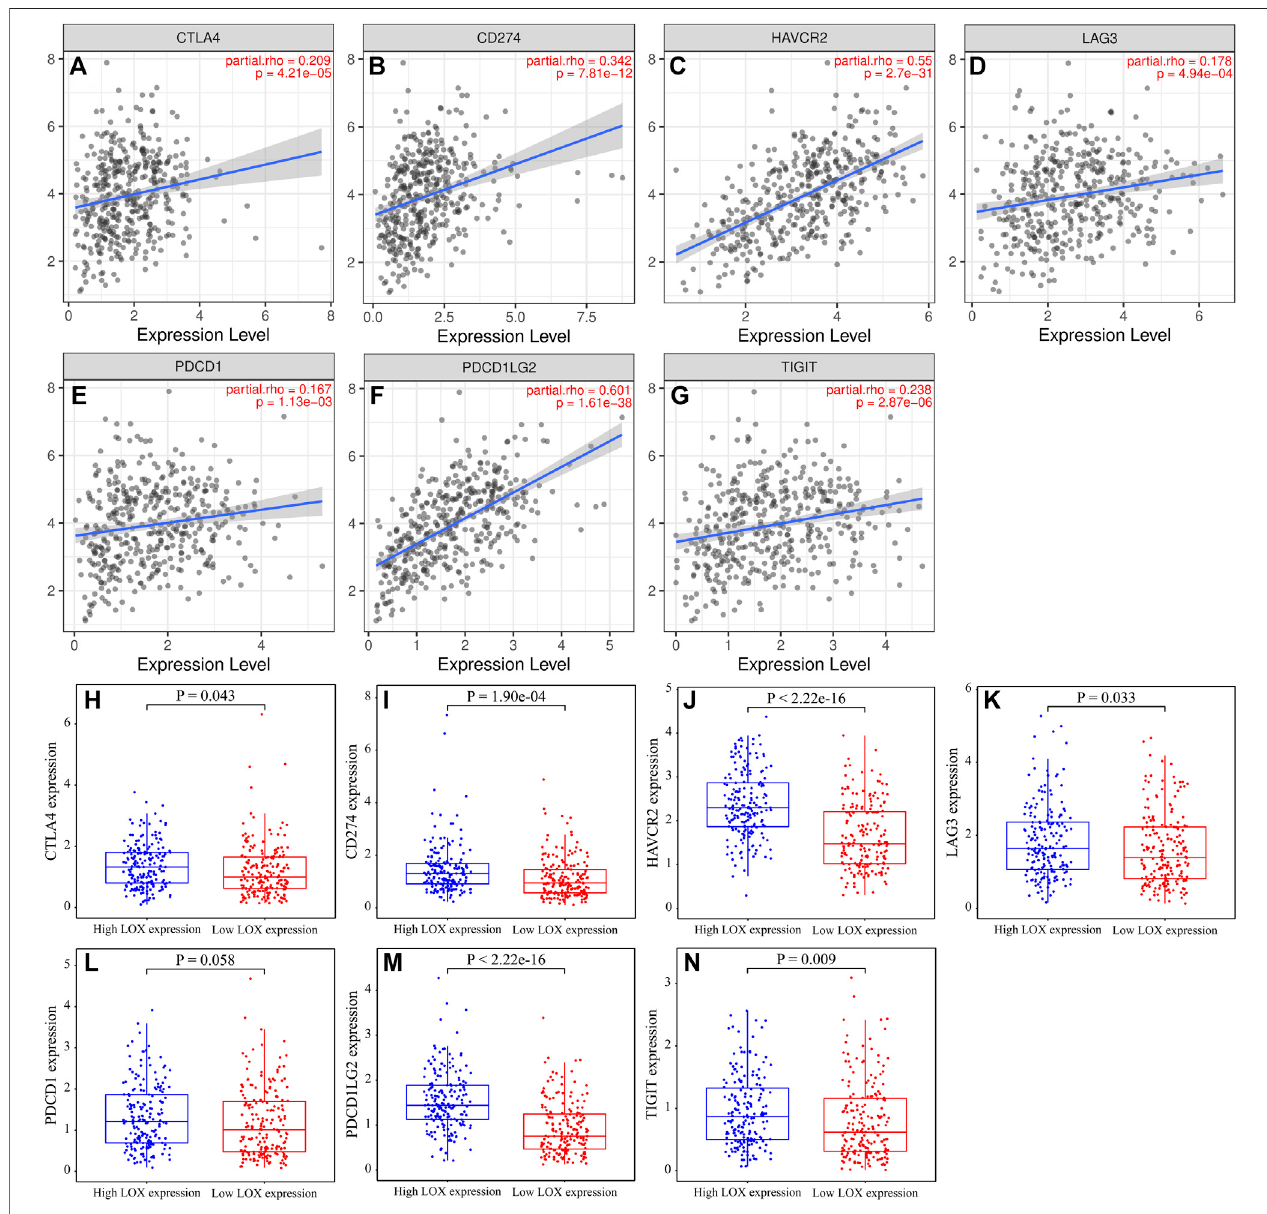
FIGURE 8 | The overexpression of LOX was negatively correlated with chemotherapeutic drug sensitivity. (A – H) The correlation between LOX expression and chemotherapeutic drug sensitivity, including fl uorouracil (A) , oxaliplatin (B) , docetaxel (C) , methotrexate (D) , tegafur (E) , and paclitaxel (F) .